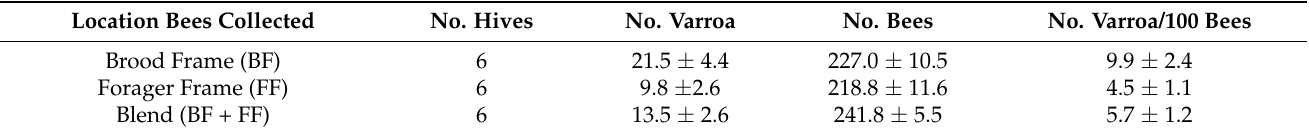
Table 4. Summary statistics (mean ± standard err (se)) for the numbers of Varroa collected in each of the bee samples, the number of bees in each sample, and number of mites adjusted as the number of mites per 100 honey bees used in tests of location in hive where honey bee samples are collected for estimation of Varroa recovery efficiency.